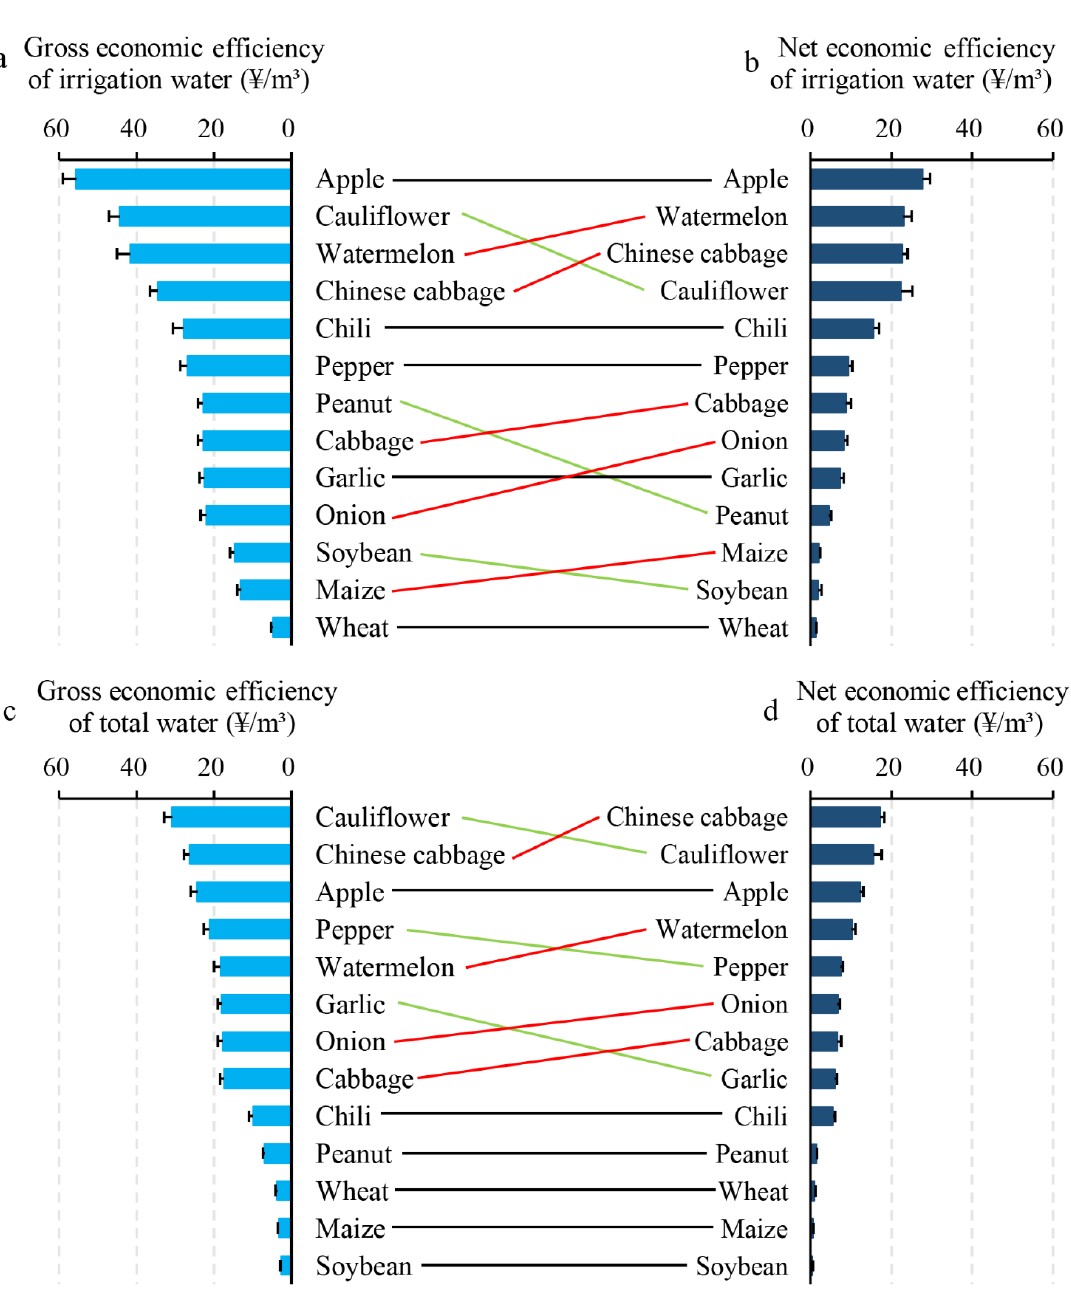
Figure 6. Economic efficiency of irrigation water and total water use for different crops with a combination of a bar chart and slope chart. The bar chart represents specific values. The slope chart represents ranking: a black line represents an unchanged ranking, a red line represents a rising ranking, and a green line represents a falling ranking (bars represent the standard deviations for different farmers).